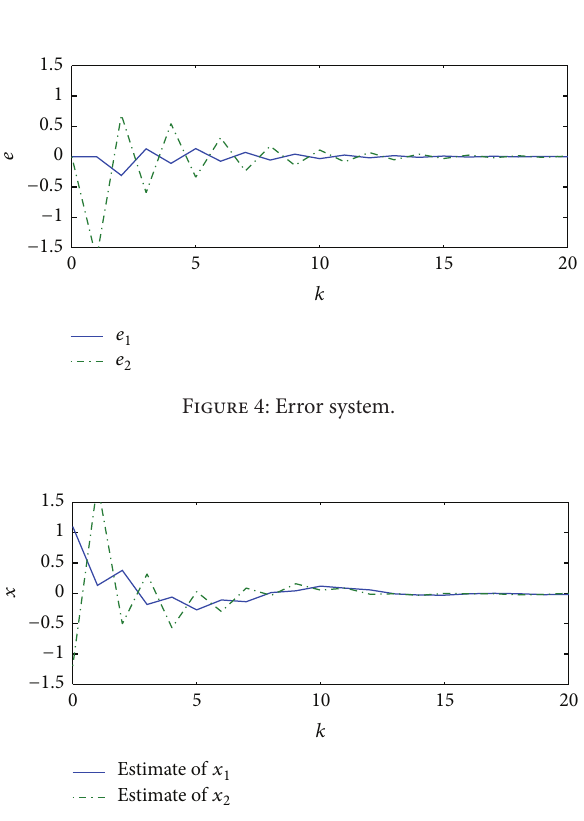
Figure 3: State of the fuzzy observer.